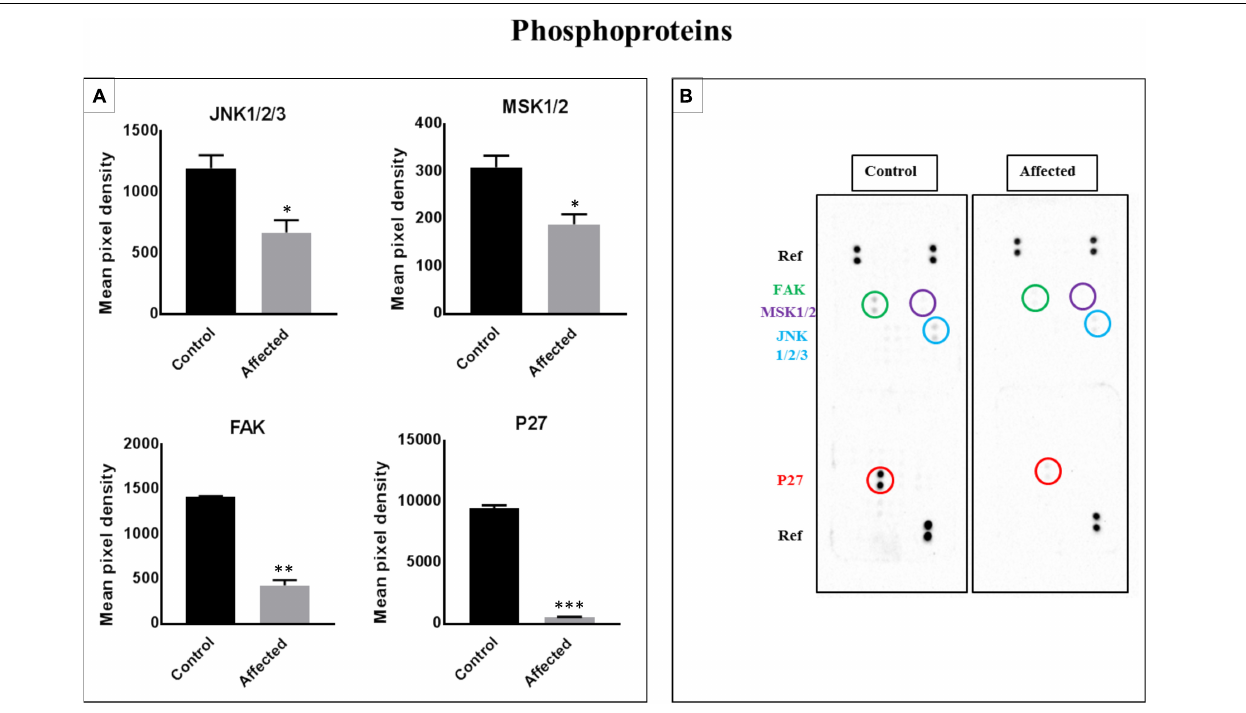
FIGURE 5 | Analysis of a proteome profiler for human phospho-kinases using PBMC cell lysates obtained from patients with the DLL-1 effect and controls. (A) Data represent the densitometric analysis of phosphorylated signaling proteins in PBMCs. Phosphorylation levels of p27, FAK, MSK1/2, and JNK1/2/3. Data are presented as means ± SEM. Data were analyzed using the paired t -test. ∗ P < 0.05, ∗∗ P < 0.01, and ∗∗∗ P < 0.0005 vs. control. (B) Part A and B of each array were incubated with 200 µ g of cell lysate. Data shown are from a 5-min